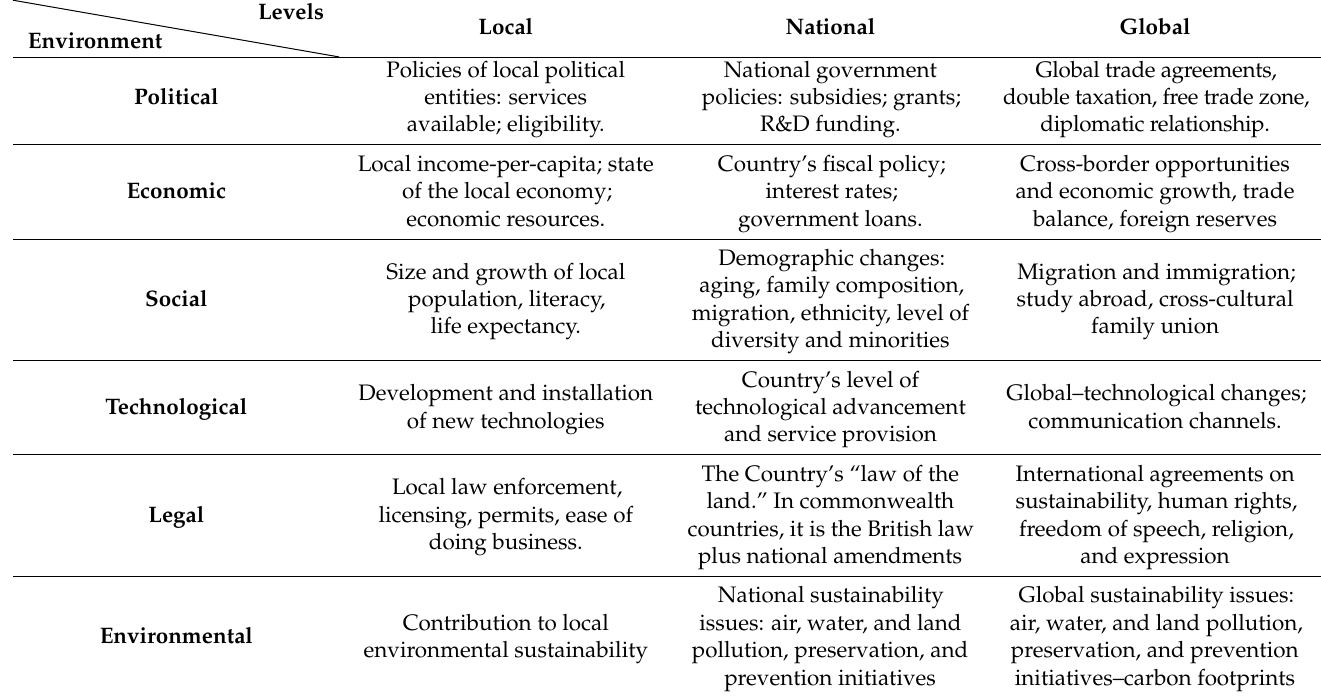
Table 9. Sample global long PESTLE analysis summary by